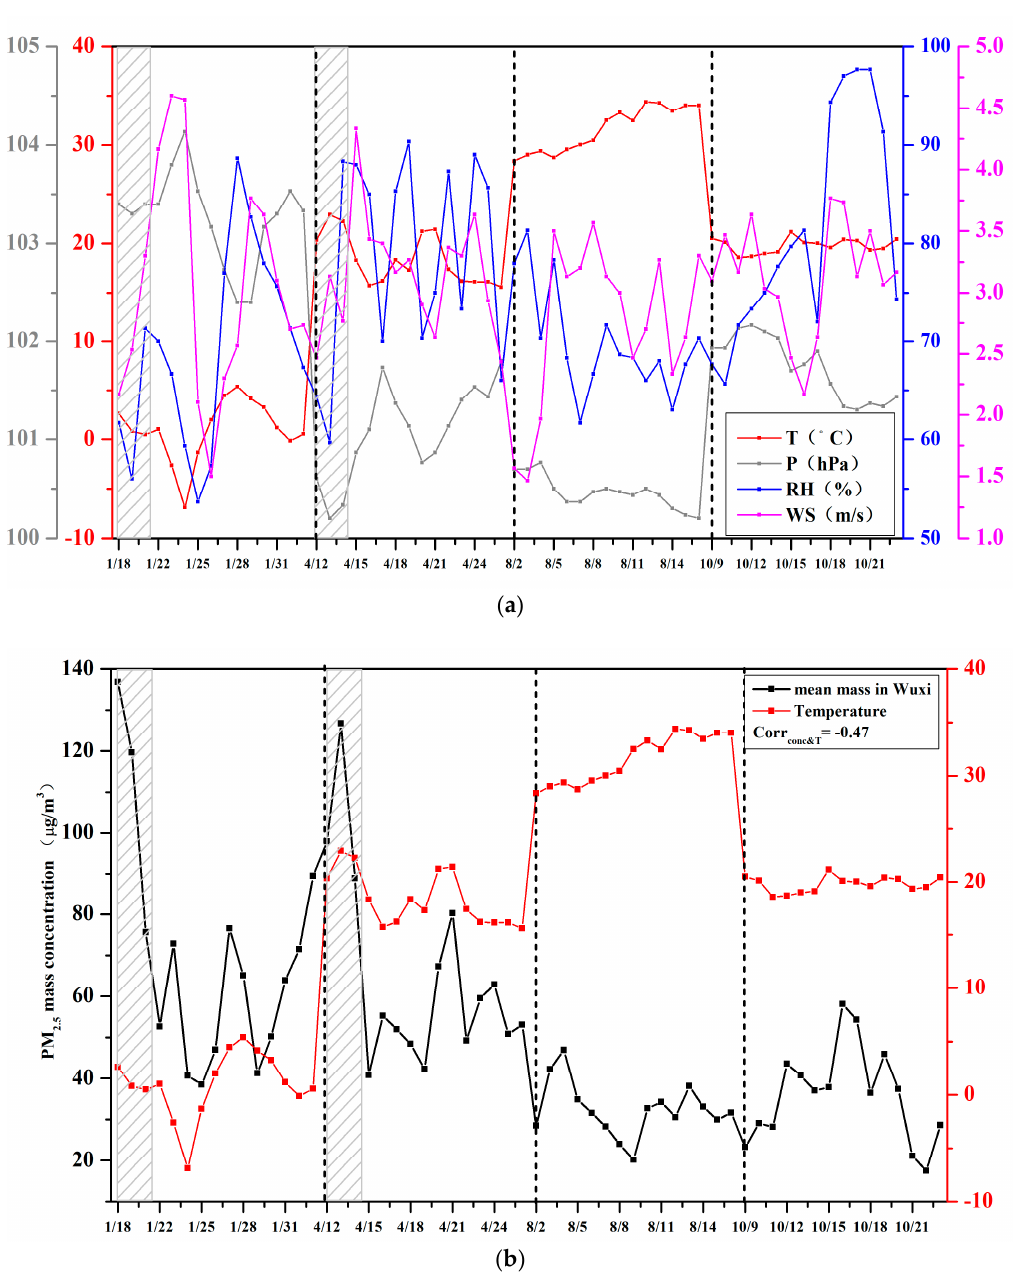
Figure 3. Temperature, pressure, relative humidity, and wind speed measurements during the sampling periods ( a ). PM 2.5 mass concentrations and temperature measurements during the sampling periods ( b ). Table 2. Meteorological characteristics during the sampling periods and the correlation coefficient with PM 2.5